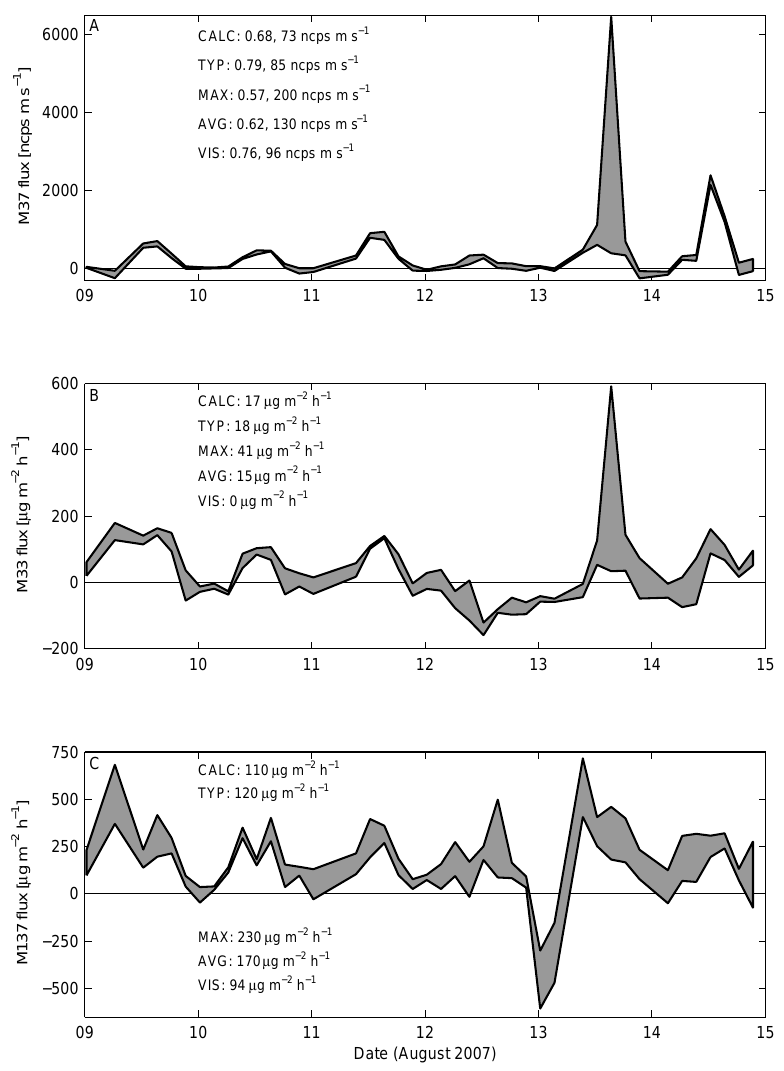
Fig. 6. Range of the M37, M33, and M137 fluxes determined with the five lag time methods (Sect. 2.4). The numbers show the median fluxes and ( A ) the correlation coefficients between the M37 flux and the reference H 2 O flux.